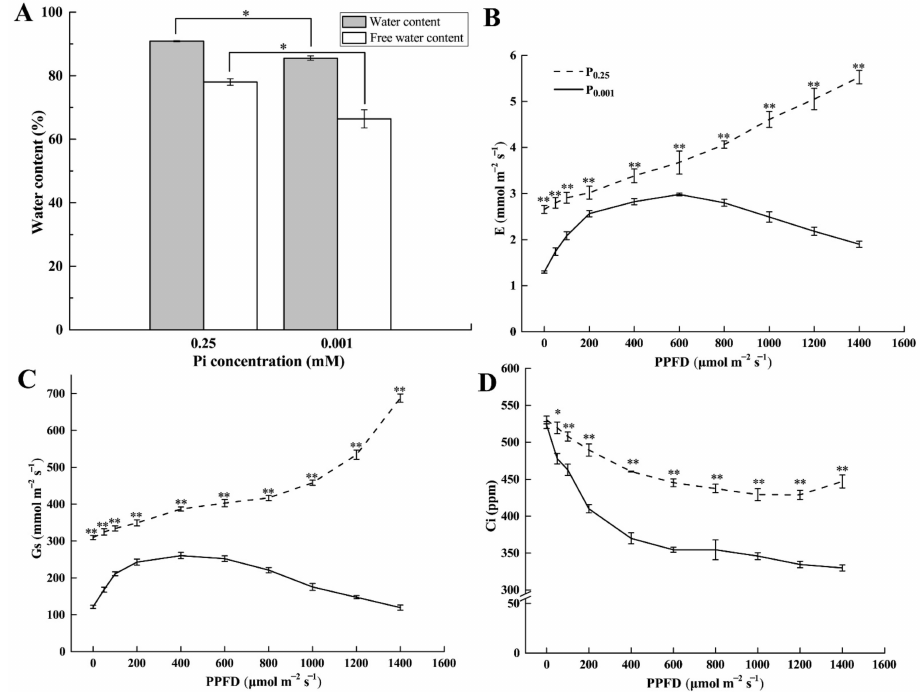
Figure 2. Leaf water content, free water content ( A ); E: transpiration rate ( B ); Gs: stomatal conduc- tance ( C ); and Ci: intercellular CO 2 concentrations ( D ) under the different Pi treatments. The error bars indicate SD ( n = 4). The asterisks indicate the significant differences according to Tukey’s test using one-way ANOVA (* p < 0.05; ** p <